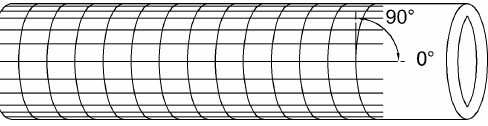
Figure 1. Cross-ply laminates.